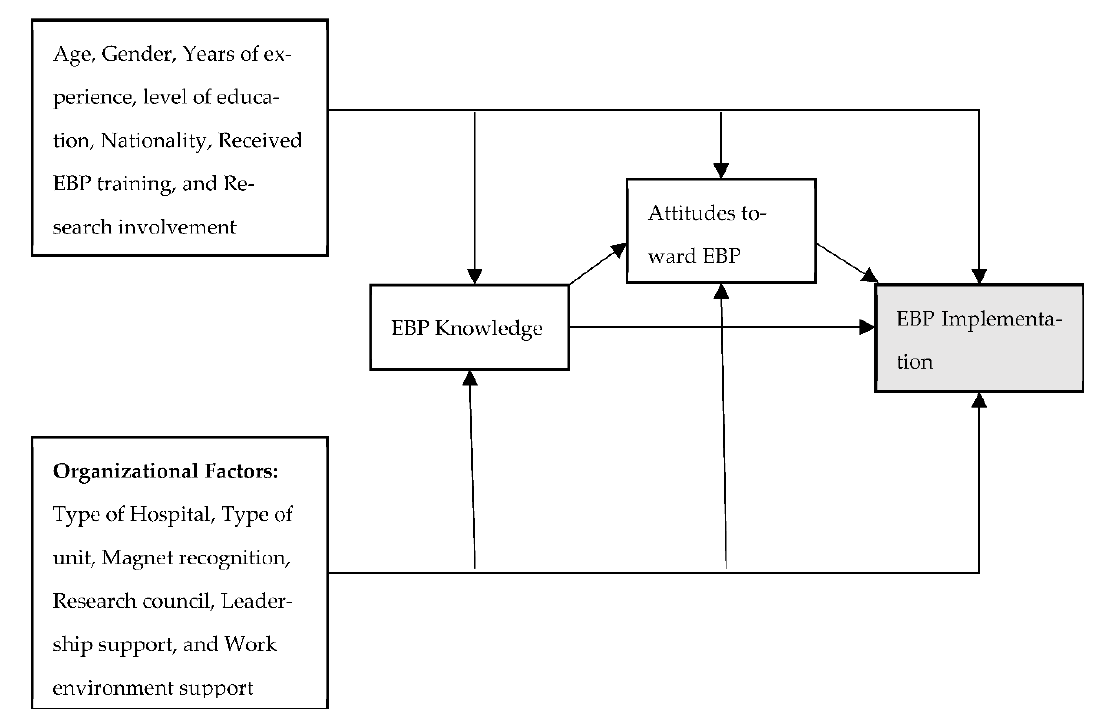
Figure 1. The study conceptual model.